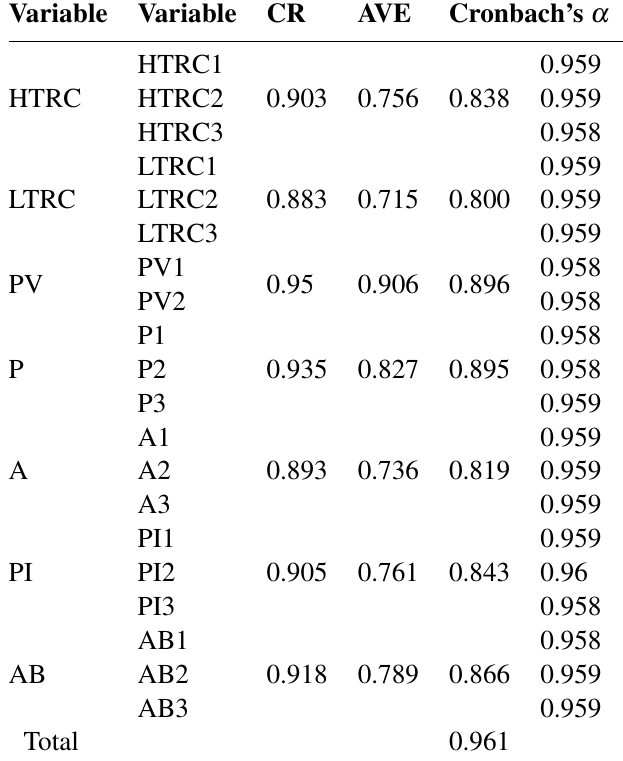
Table 3 Combination reliability test.